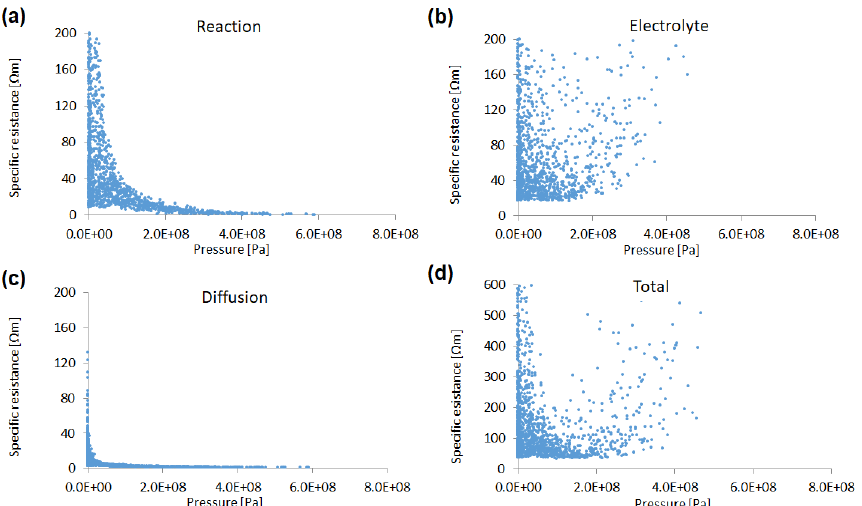
Figure 5. Sensitivities of ( a ) reaction resistance, ( b ) electrolyte resistance, ( c ) Li diffusion resistance, and ( d ) total specific resistance to the pressure, with a total of 2100 simulation results.